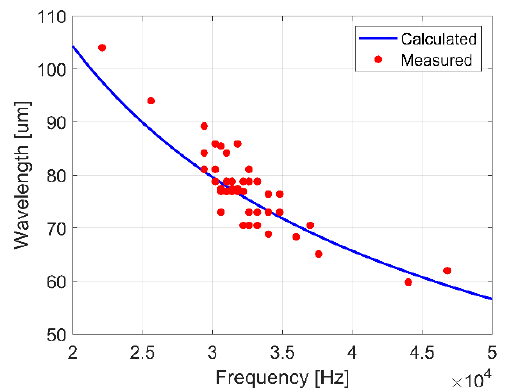
Figure 9. Comparison of the calculated wavelength for 1-D capillary waves on a flat liquid surface to measured wavelengths for surface waves on 10–70 µL droplets of deionized water vibrated at frequencies between 20 and 50 kHz.